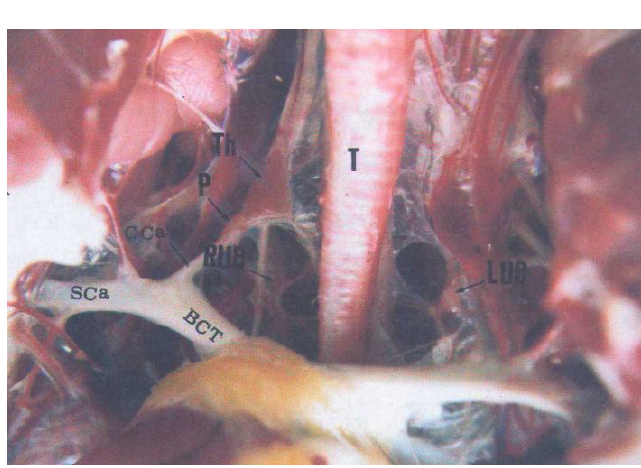
Figure ( 1): Ventral vi ew of th e bl ood vessels, ner ves and position of the ultimobranchial gland at the thoracic inlet of the geese. PT: pulmonary trunk; RA: right atrium; LA: left atrium; A: aorta; JV: jugular vein; BCT: brachiocephalic trunk; CCa: commom carotid artery; SCa: Subclavian artery; SCv: Subclavian vein; Pa: Pulmonary artery; Vn: vagus nerve; Rn: recurrent nerve; o:esophagus; T: Trachea; PB: ultimobranchial gland .